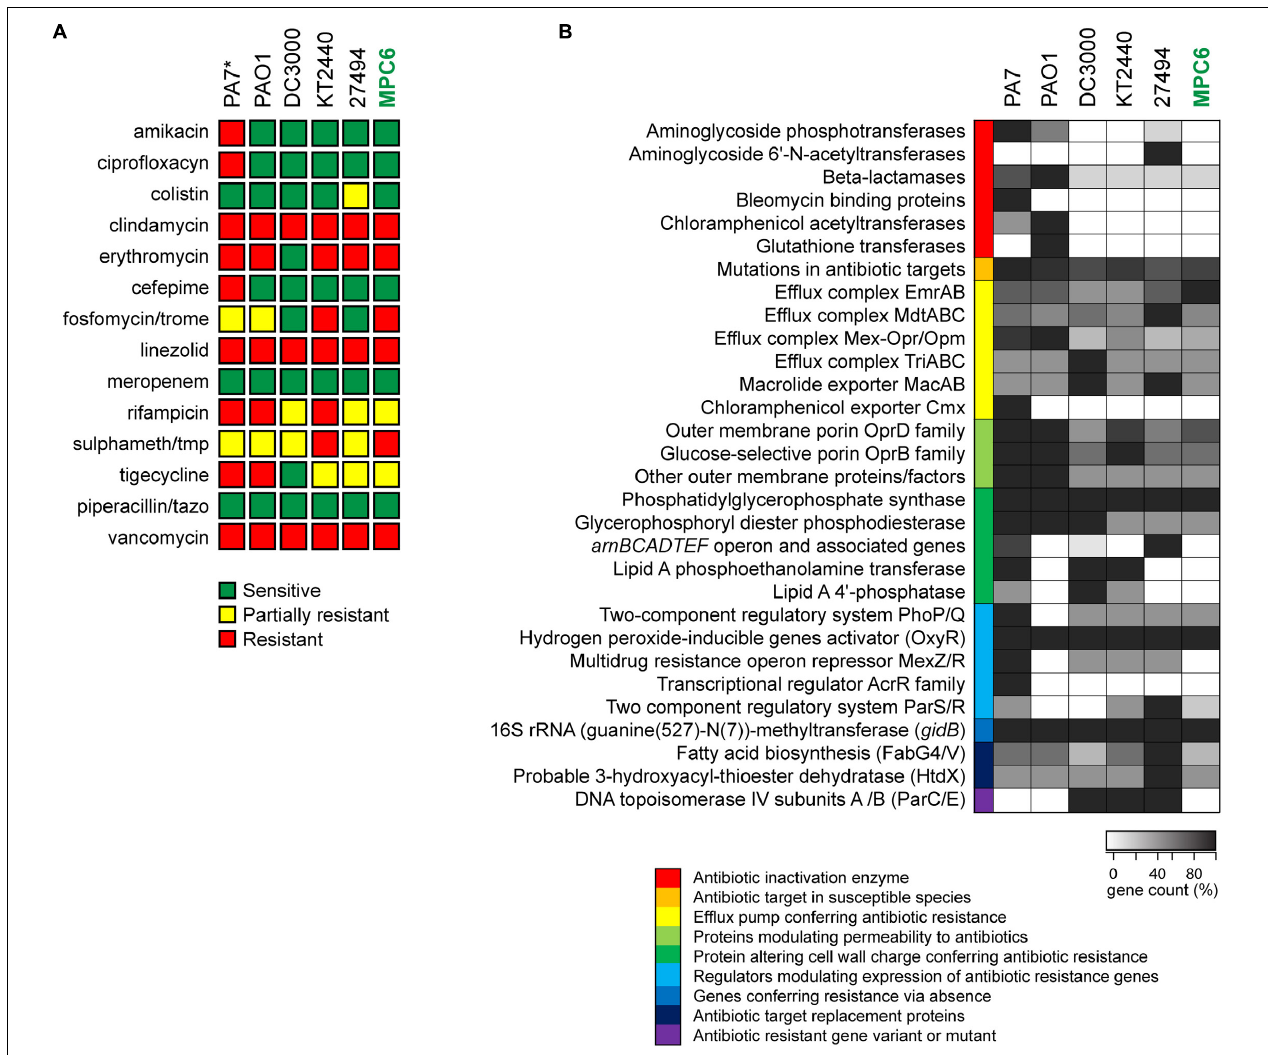
FIGURE 6 | Antimicrobial resistance properties of Pseudomonas sp. MPC6 compared to other strains from this genus. (A) Susceptibility to different classes of antibiotics determined by disk diffusion assays. ∗ The profile shown for P. aeruginosa PA7 was not determined experimentally in this work and was built based on previous studies. (B) Antimicrobial resistance profile determined based on genomic analyses. Putative factors associated to drug resistance were grouped into different categories that are depicted with different colors. The gene count for each category in each strain was plotted as a heatmap, were the darkest tone (100%) corresponds to the highest number of genes found in each category among all